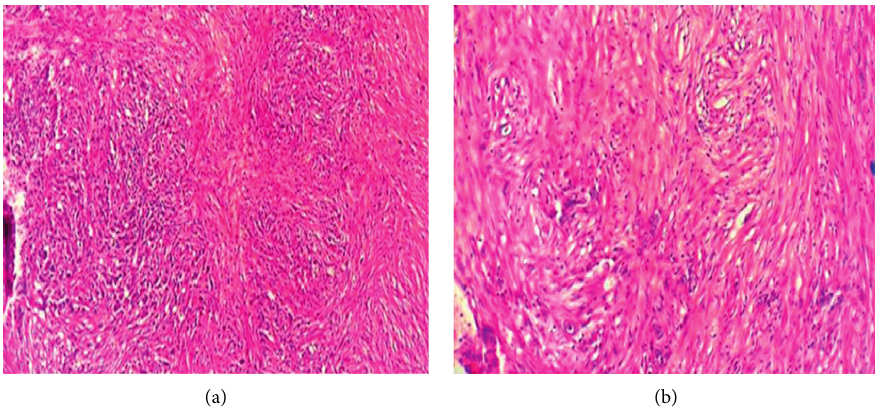
Figure 3: Sarcomatoid carcinoma presenting round cells, giant pleomorphic cells, and spindle-shaped anisokaryocytic cells. (A) HE original magnification × 100. (B) HE original magnification × 200.